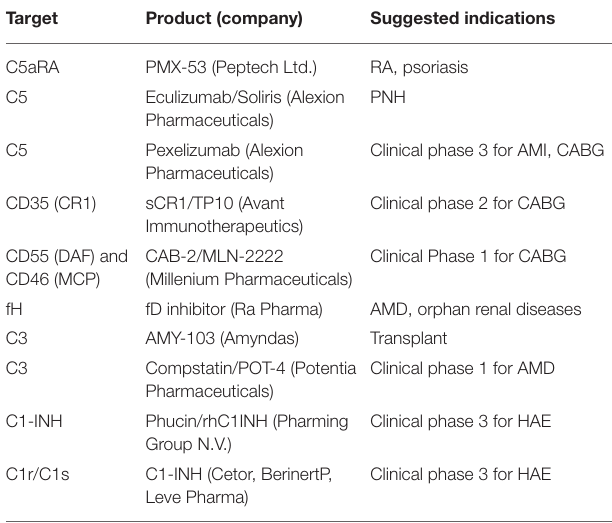
TABLE 2 | Current drug candidates to target complement